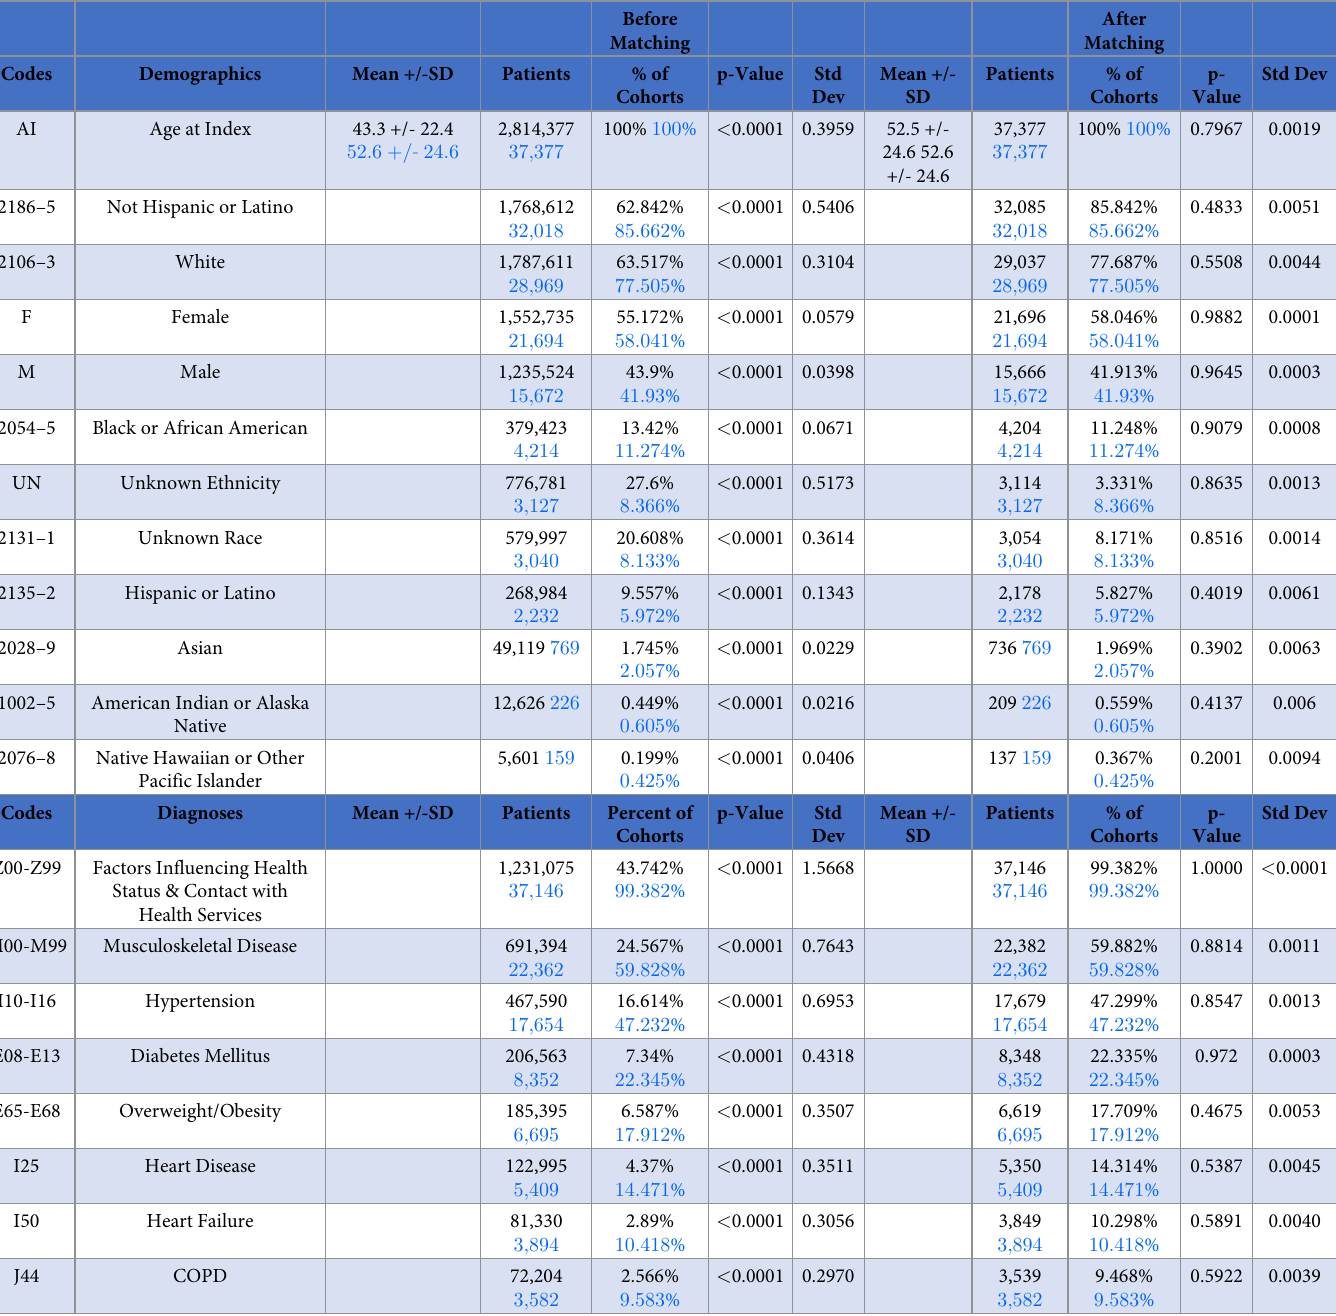
Table 1. Propensity score matching results, all factors were significantly different between the 2 cohorts prior to matching (p < 0.0001).